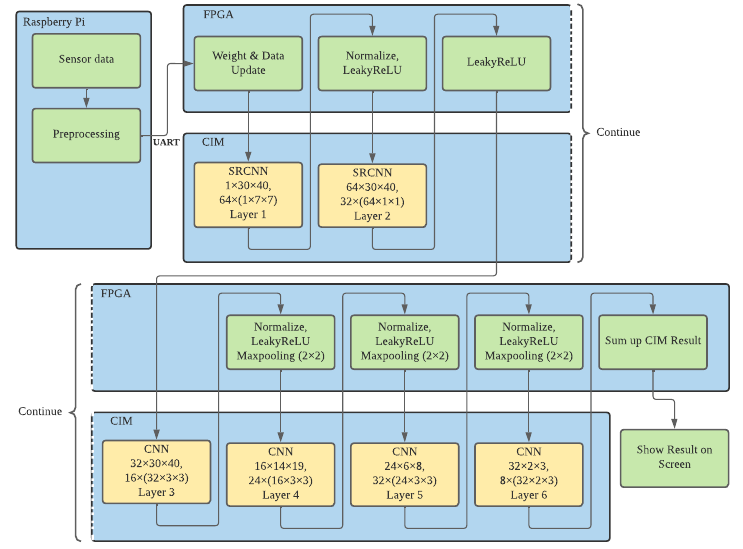
Figure 11. Network Architecture for Pose